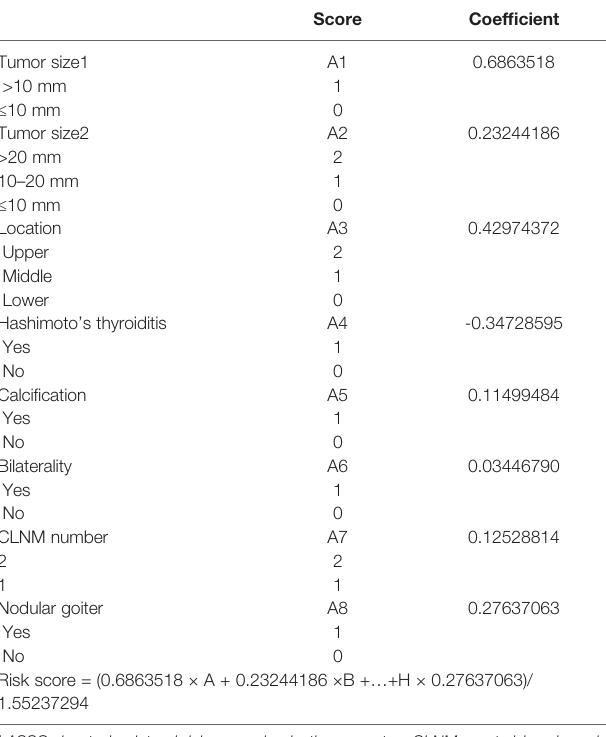
Score Coef fi cient